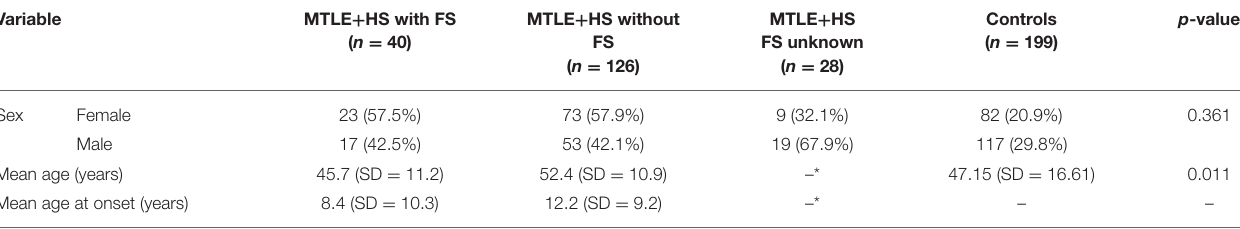
TABLE 1 | Descriptive statistics of patients with MTLE + HS and controls ascertained for the genetic association study. Variable